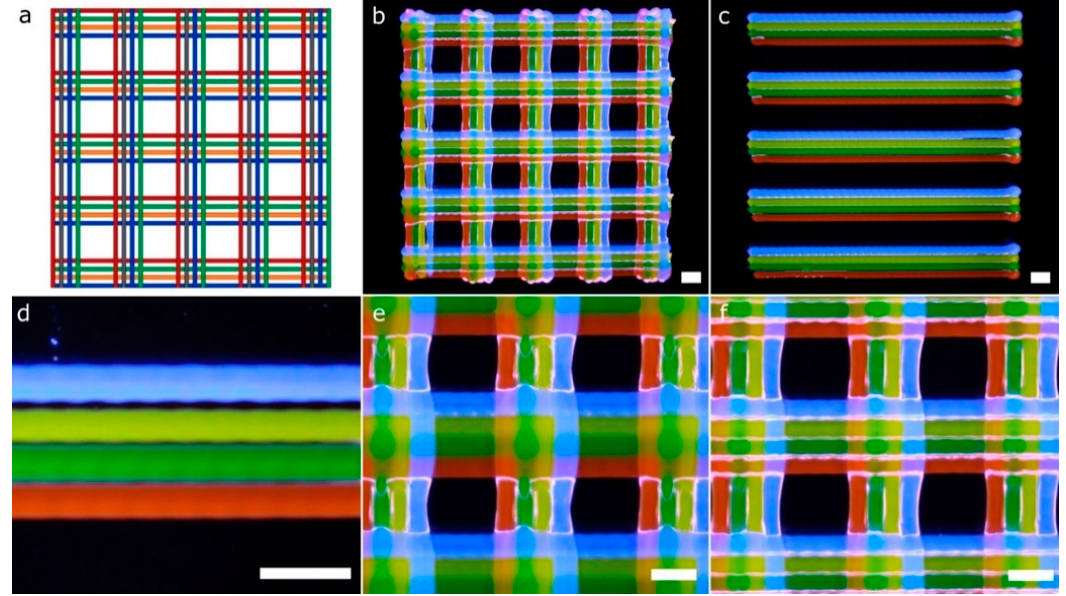
Figure 12. Pictures of a complex porous structure printed using four printheads and rectilinear patterns. The four printheads deposited dyed P407 in the same layer with a total of two layers stacked. General view of the CAD design ( a ) and printed porous structure ( b ); ( c ) general view of the first layer; ( d ) detailed view of printheads misalignments on the y -axis; ( e ) detailed view of strands diffusion in the second layer; ( f ) detailed view of the porous structure printed correctly. Scale bars: 1 mm.